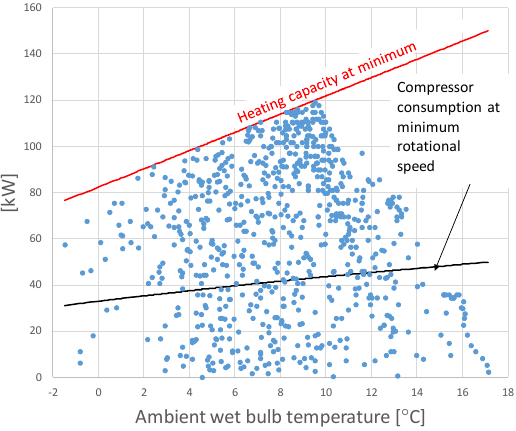
Figure 9. Thermal demand points in on/off operation mode versus the ambient wet bulb temperature. Heating capacity and compressor consumption at minimum rotational speed are also plotted.